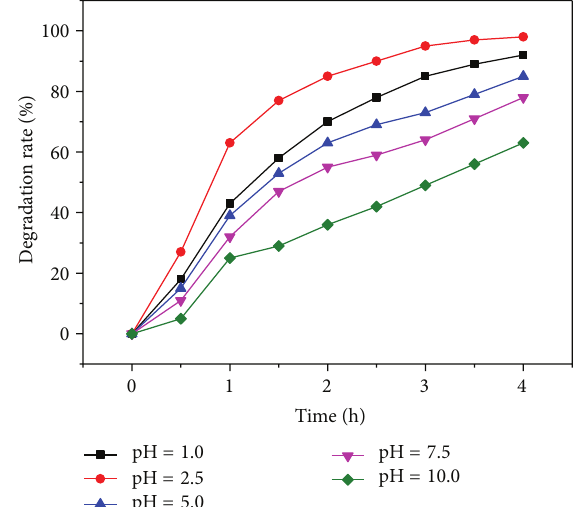
Figure 6: Effects of initial dye concentration on photocatalytic activity of catalyst.